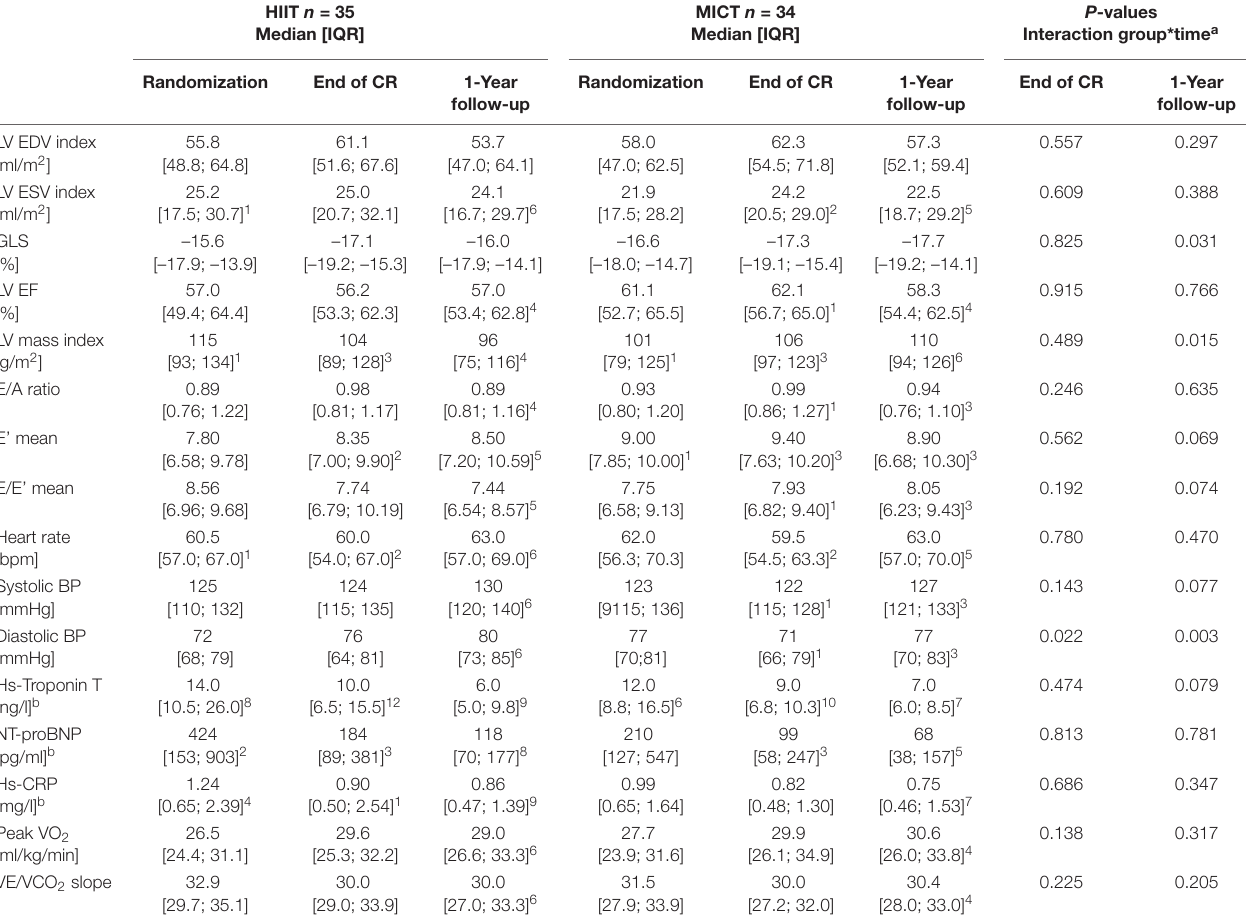
TABLE 2 | Left ventricular echocardiography parameters, biomarkers, and cardiorespiratory fitness at randomization, end of CR, and 1-year follow-up.